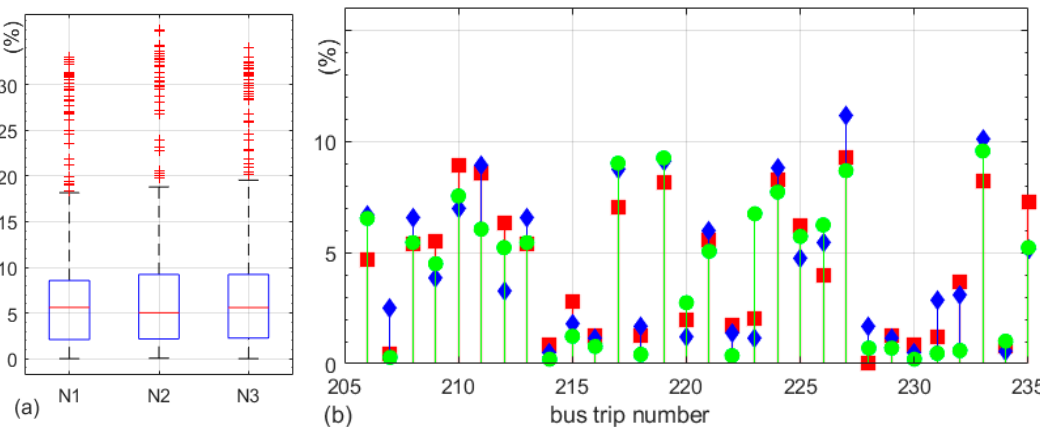
Figure 8. Absolute value of estimation errors for networks N1, N2, N3: ( a ) box plots and ( b ) stem plots of an example range of bus trips used in the testing.